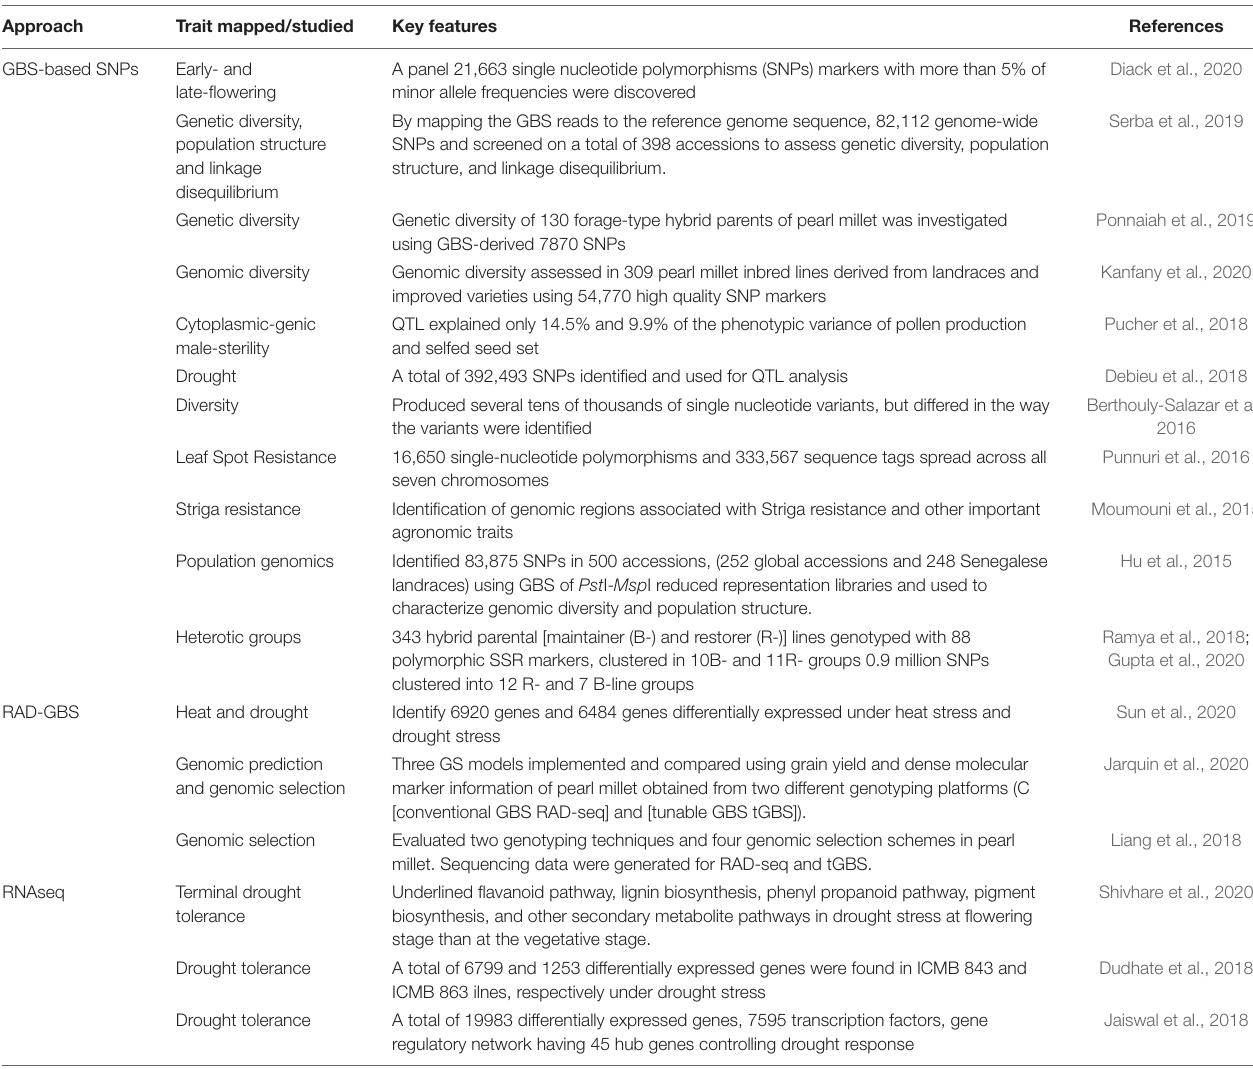
TABLE 3 | Key sequence-based markers and their application in various genomic studies on pearl